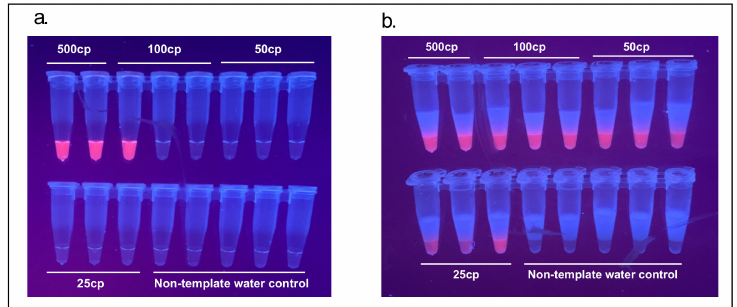
Figure 6. LoD improvement with a 2-step system ( a ) 1-Step RT-LAMP limit of detection (LoD) confirmed to be at ~500 copies of Twist Biosciences SARS-CoV-2 control as reported by Zhang et al. 2020; ( b ) 2-step RT/LAMP cartridge with increased sensitivity with LoD down to 25 copies of Twist Biosciences SARS-CoV-2 control.